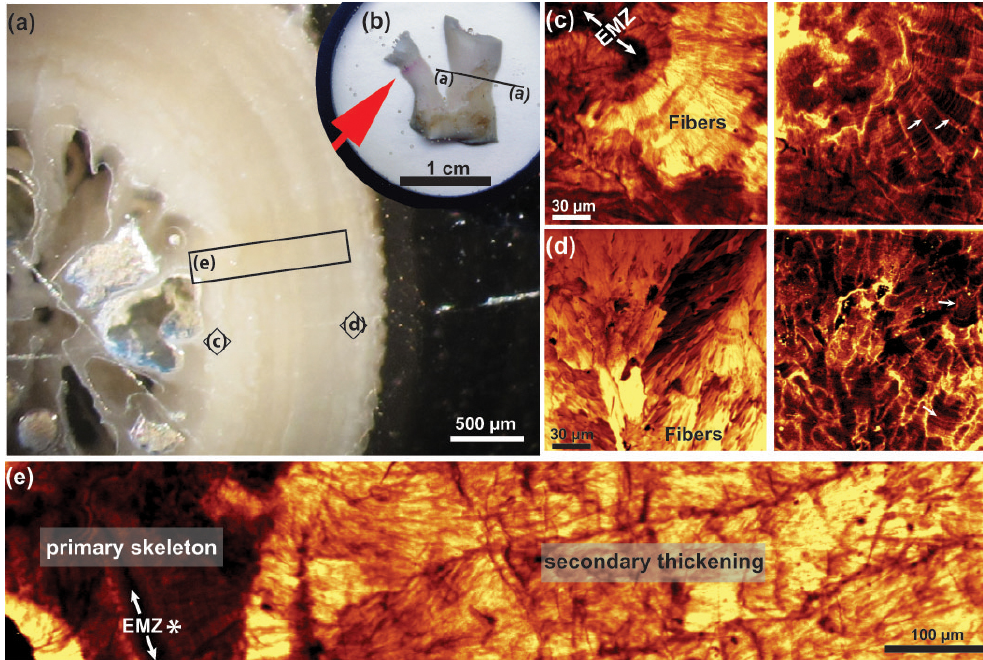
Figure 1. Lophelia pertusa colony (a) cut in transversal plane of an old branch and (b) Lophelia colony cut in longitudinal plane with two branches (old and a young branch). The young side branch shows the Alizarin stain. (c, d) Raman maps of aragonite fibre orientation (left map) and fluorescence (right map) within the primary skeleton with early mineralization zone (EMZ; c ) and within the secondary thickening (d) . The arrows in (c, d) mark skeletal organic matrix bands. (e) Raman maps of aragonite fibre orientation clearly differentiating primary skeleton and secondary thickening of the corallite and early mineralization zone